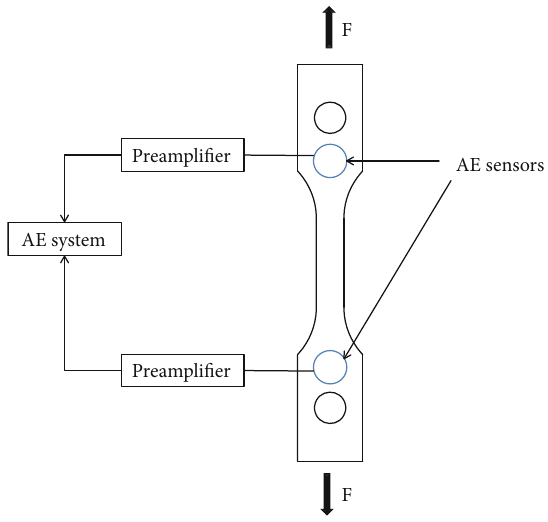
Figure 4: Schematic of the experimental process. Two acoustic emission sensors are fi xed on the surface of the specimen to collect